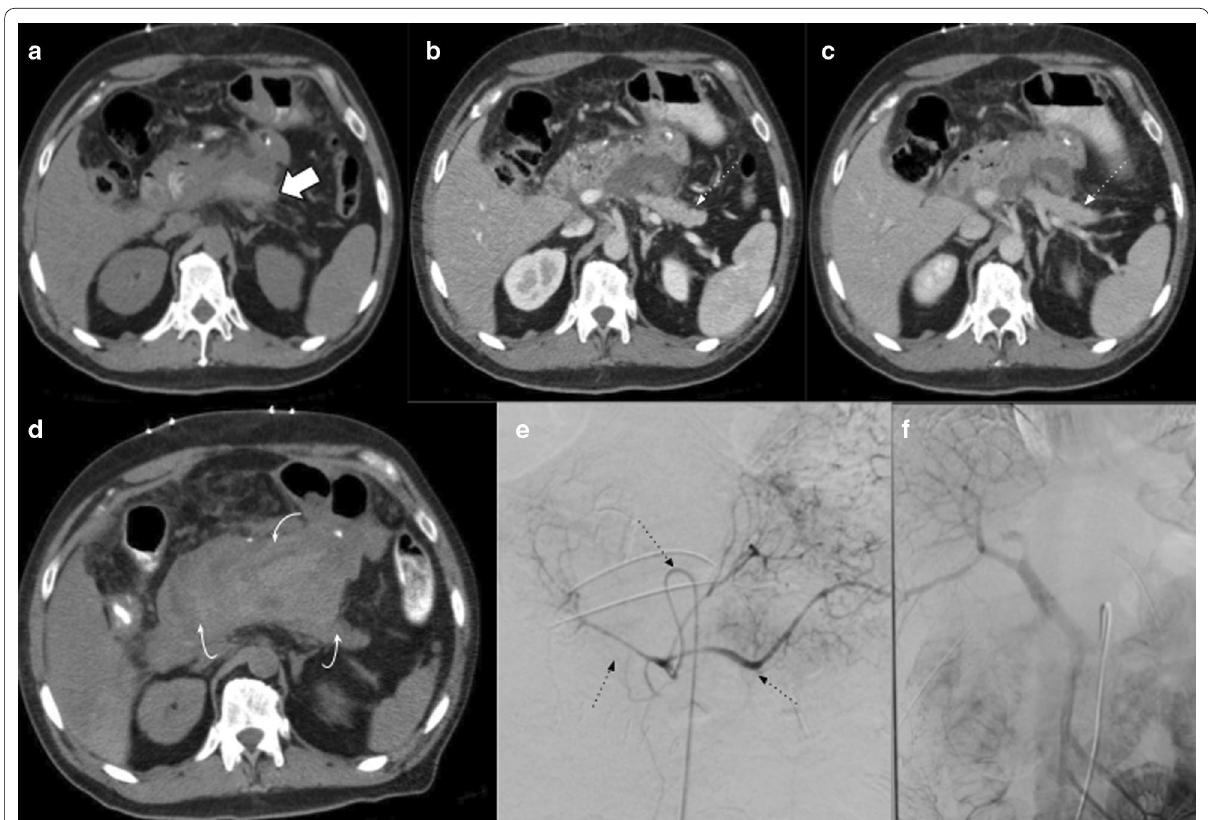
Fig. 26 Postoperative hemorrhage. 67-year-old patient during early complicated postoperative. a – c Axial non-contrast, arterial and portal venous phase, respectively. Shows blood collection in the surgical bed (thick white arrow in ( a ), no active bleeding was seen. Remnant pancreas was preserved (dotted arrow in b and c ). ( d ) CT scan performed three days later due to decreasing hematocrit shows known hematic collection increased in size (curved arrows). ( e , f ) Digital angiography shows no signs of active bleeding, but there is diffuse spasm of the celiac trunk (dotted black arrows in e ) Portal-mesenteric veins were preserved. Exploratory laparotomy confirms hemoperitoneum with retroperitoneal branch-dependent